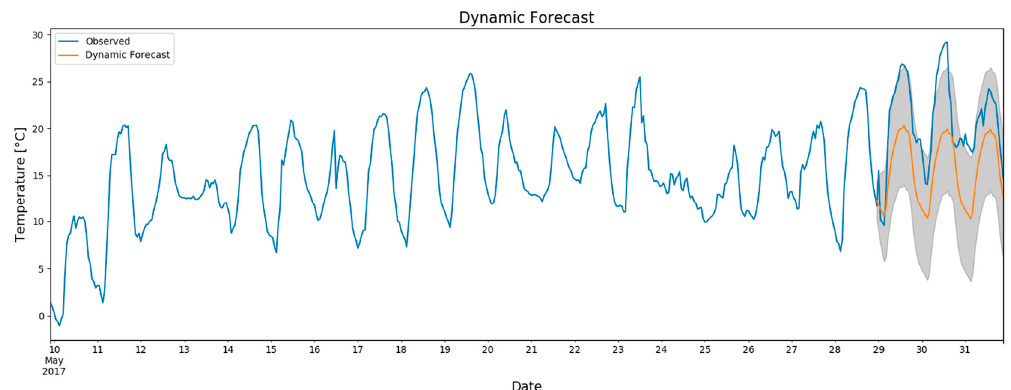
Figure 14. Training data and forecasting result in the dynamic mode for the raw temperature data time series obtained from the IBIS measurements for a SARIMAX (1, 0, 2) × (0, 1, 2) 24 model.